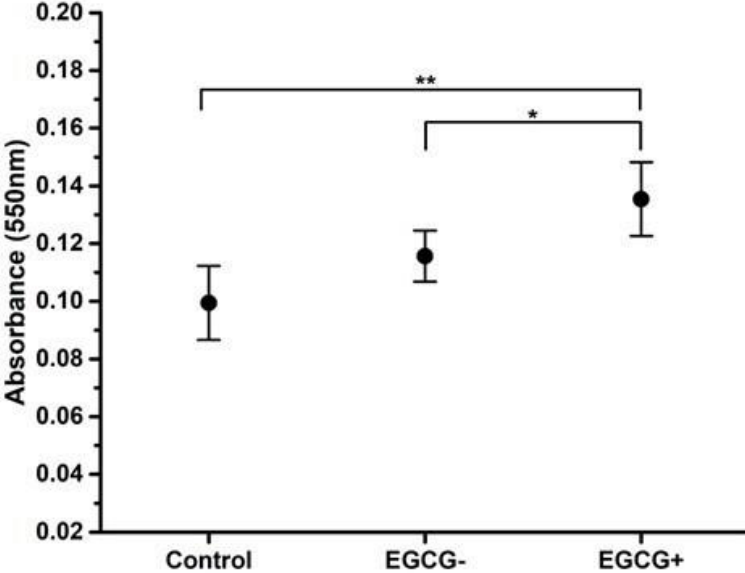
Figure 5. Alizarin red calcified deposits dissolved of hDPSC differentiation to odontoblast-like cells. hDPSCs (100% confluence, 6 PDL) were subcultured and promoted to odontoblastic-like differentiation control, with or without medium containing 3.12 µg/mL of EGCG for 10 days. The calcified deposits after alizarin red stains were dissolved with extraction of 5% 2-isopropanol and 10% acetic acid solution for 16 h. Each value represents the mean ± SD of triplicate assays ( n = 24), * p < 0.05, ** p < 0.01 ANOVA post hoc Tukey test. Absorbances, 550 nm (0.061; 0.1675). EGCG = (-)- Epigallocatechin - Gallate ; hDPSCs = human dental pulp stem cells; PDL = population doubling level; SD = standard deviation.